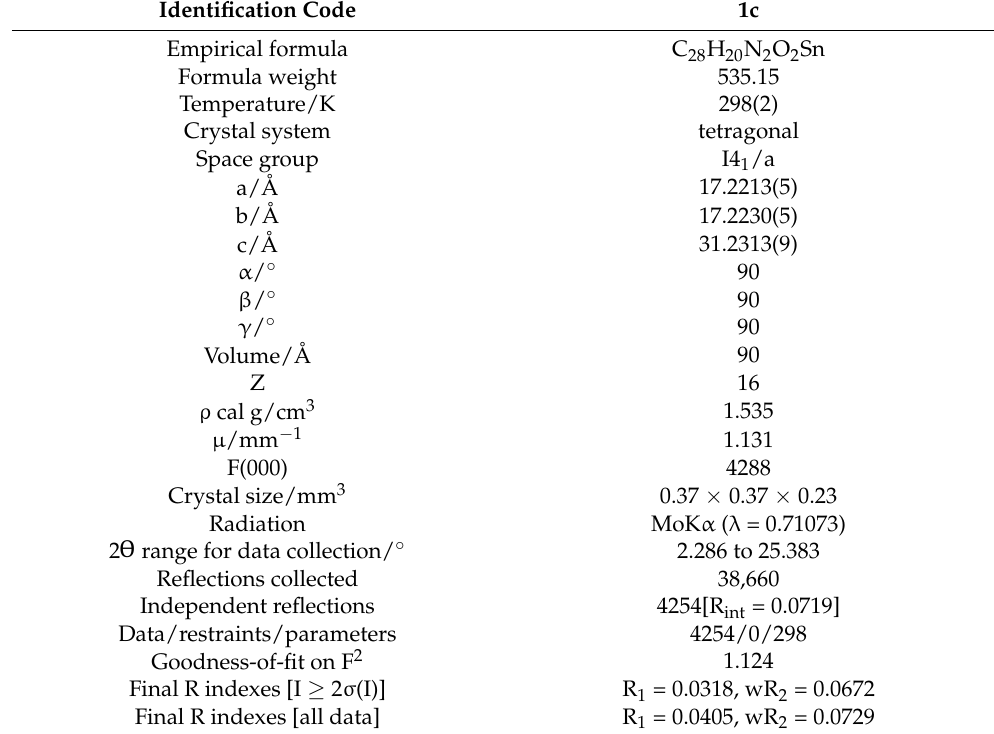
Table 1. Crystallographic and structure refinement data for compound 1c .